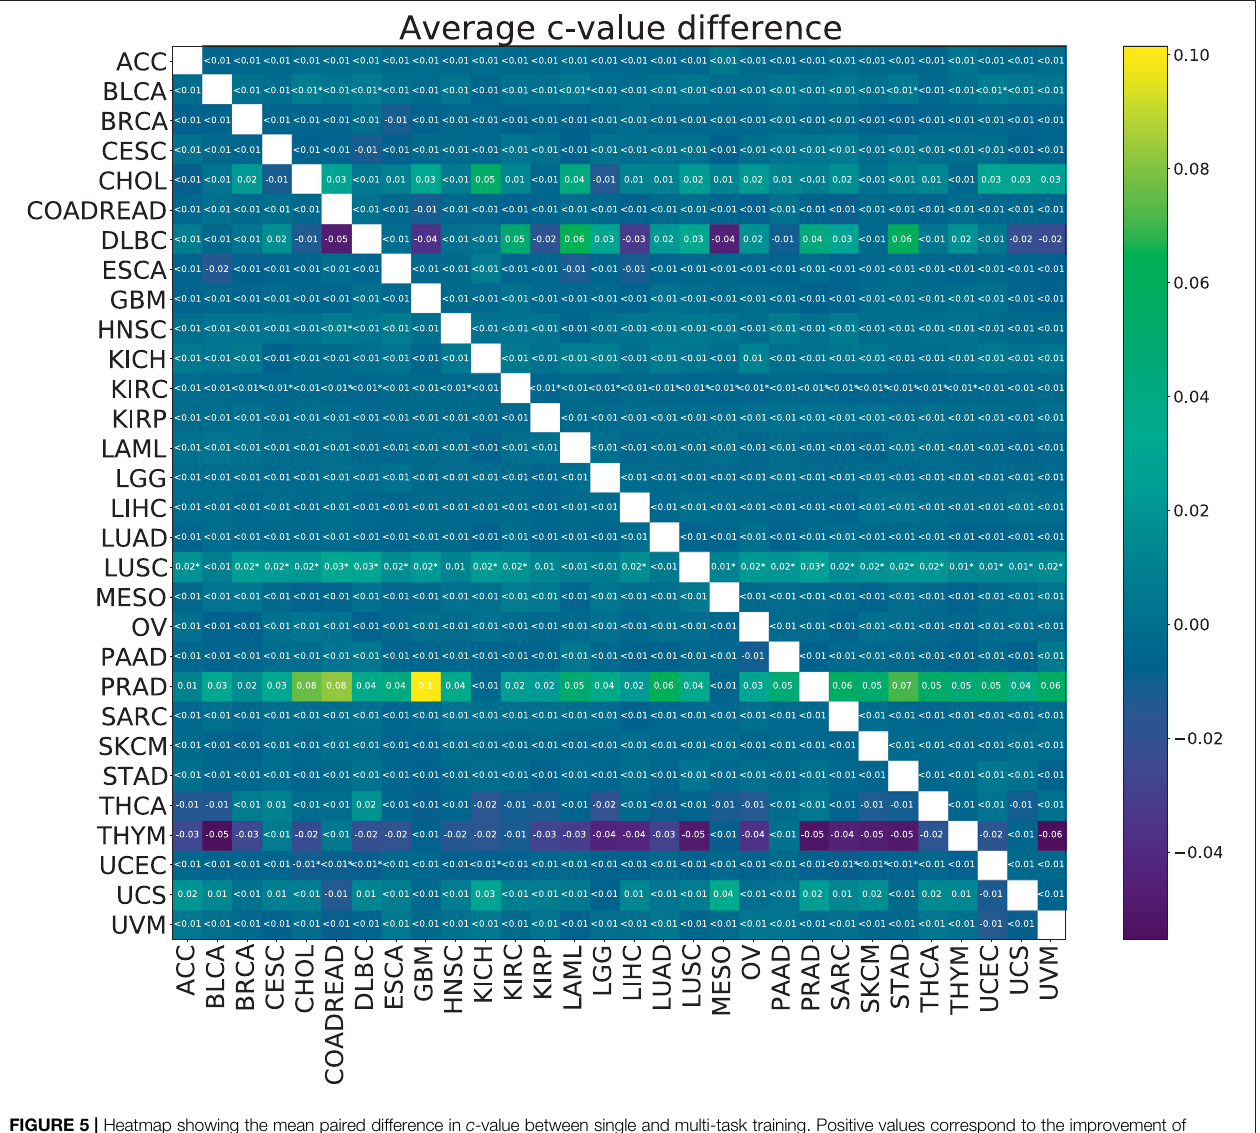
FIGURE 5 | Heatmap showing the mean paired difference in c -value between single and multi-task training. Positive values correspond to the improvement of model prediction accuracy with multi-tasking. The rows correspond to cancer types for which the c -values were calculated and the columns to cancer types with which the target cancer was paired for the multi-task training. Asterisks (*) indicate signi fi cance with the FDR corrected p -value p < 0.05.